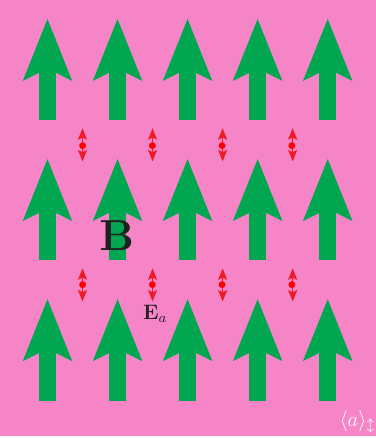
Figure 3. The resonant detection idea of the QCD axion. The E -field follows the axion vacuum oscillation.